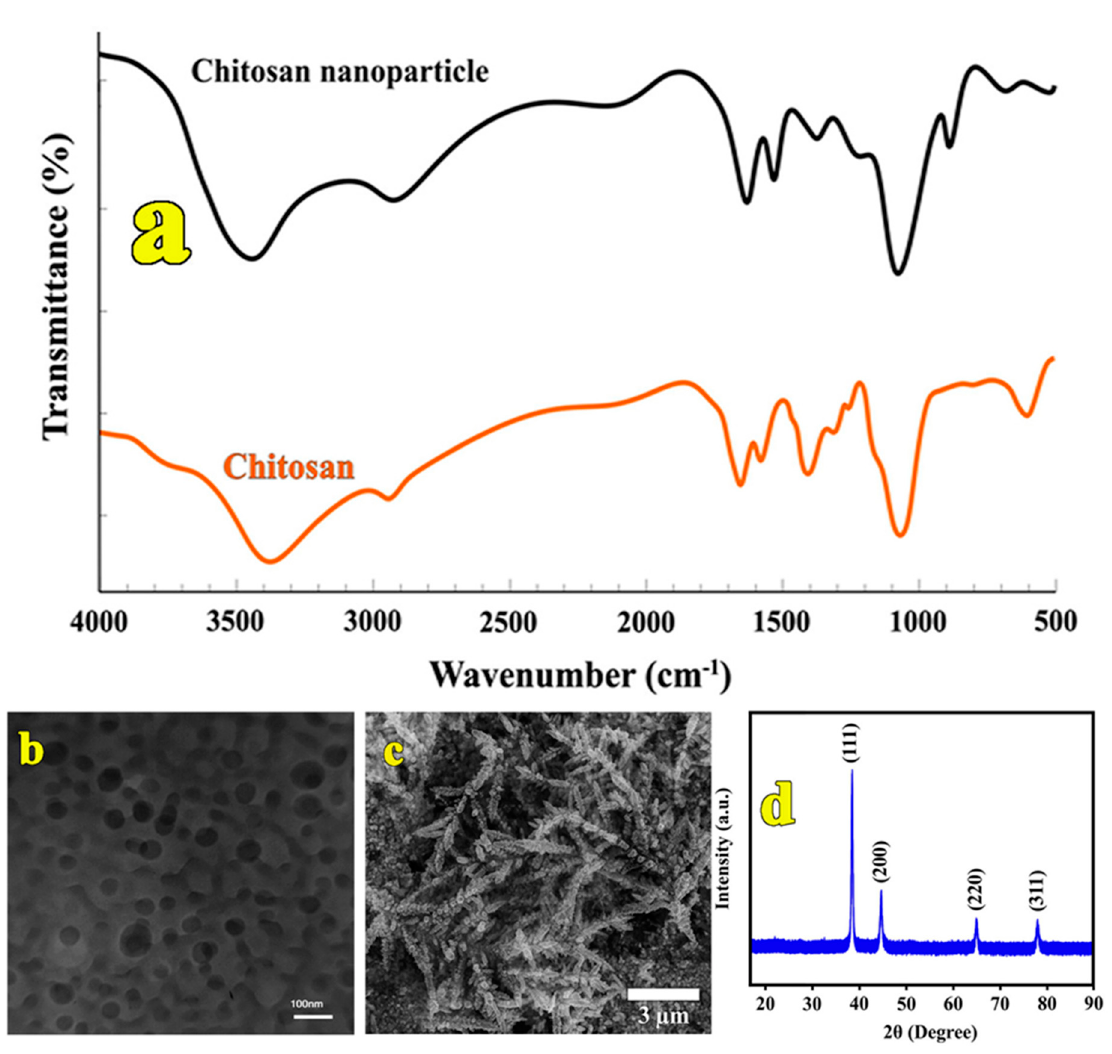
Figure 1. ( a ) FTIR spectra and; ( b ) TEM image of CNNPs; ( c ) SEM image and; ( d ) XRD pattern of AuNDs.